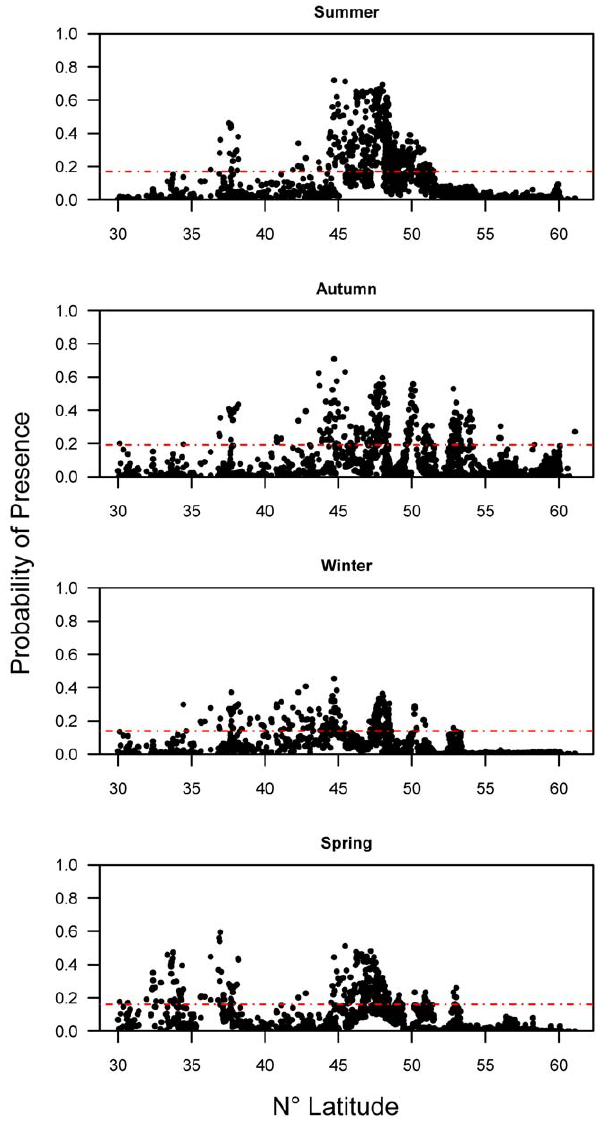
Figure 5. Seasonal probability of presence for MaxEnt background predictions. Each panel depicts the seasonal MaxEnt model predictions versus latitude for background samples. The red dashed line indicates the logistic presence-absence threshold value (described in the text) for each season.